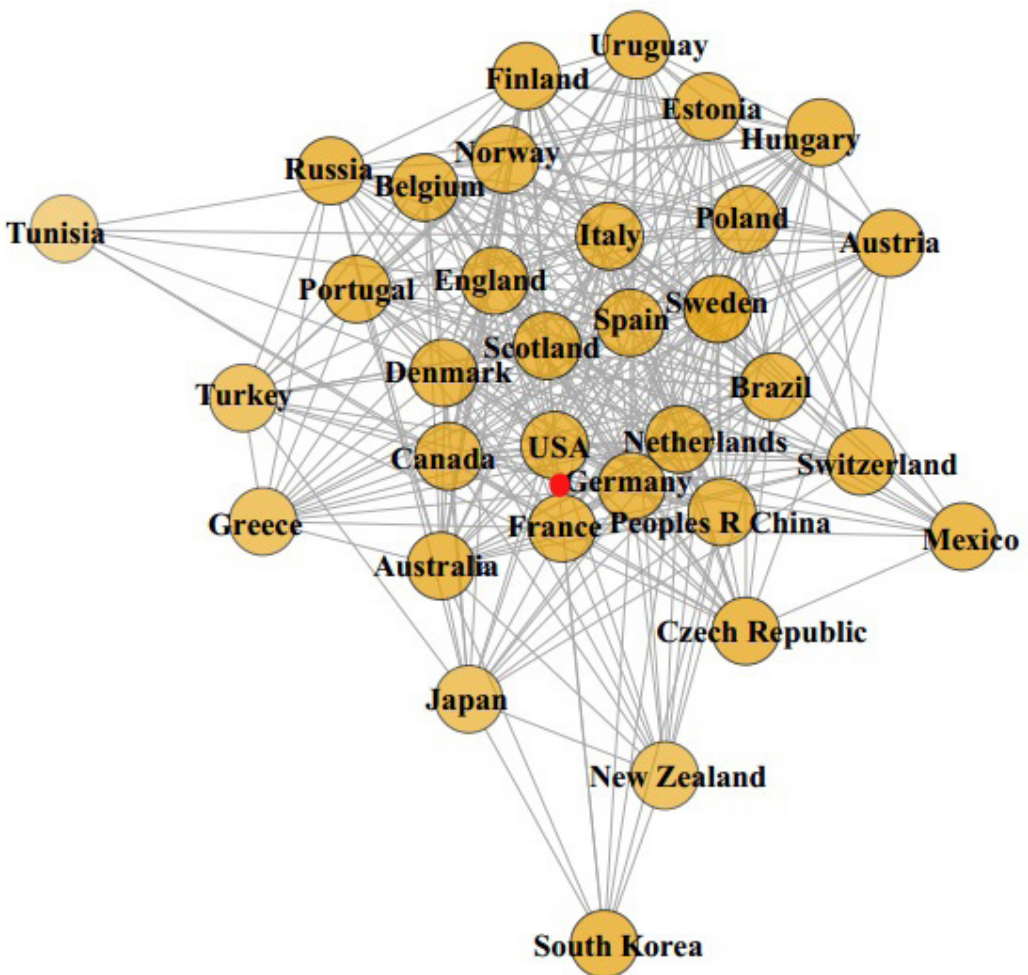
Figure 4. Collaboration among countries that collaborated in at least 20 papers. The most centralized countries had the most number of collaboration, the center of the network is represented by a red dot.